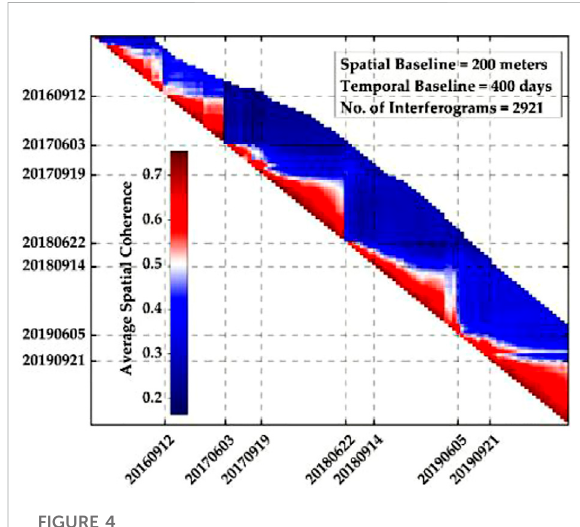
FIGURE 4 Average interferometriccoherence coef fi cients from 2015 to 2020, the vertical axis represents the period of the primary images and the horizontal axis represents the period of the secondary images. The color values of pixels represent the ASC of the interferograms (Xiang et al., 2021).